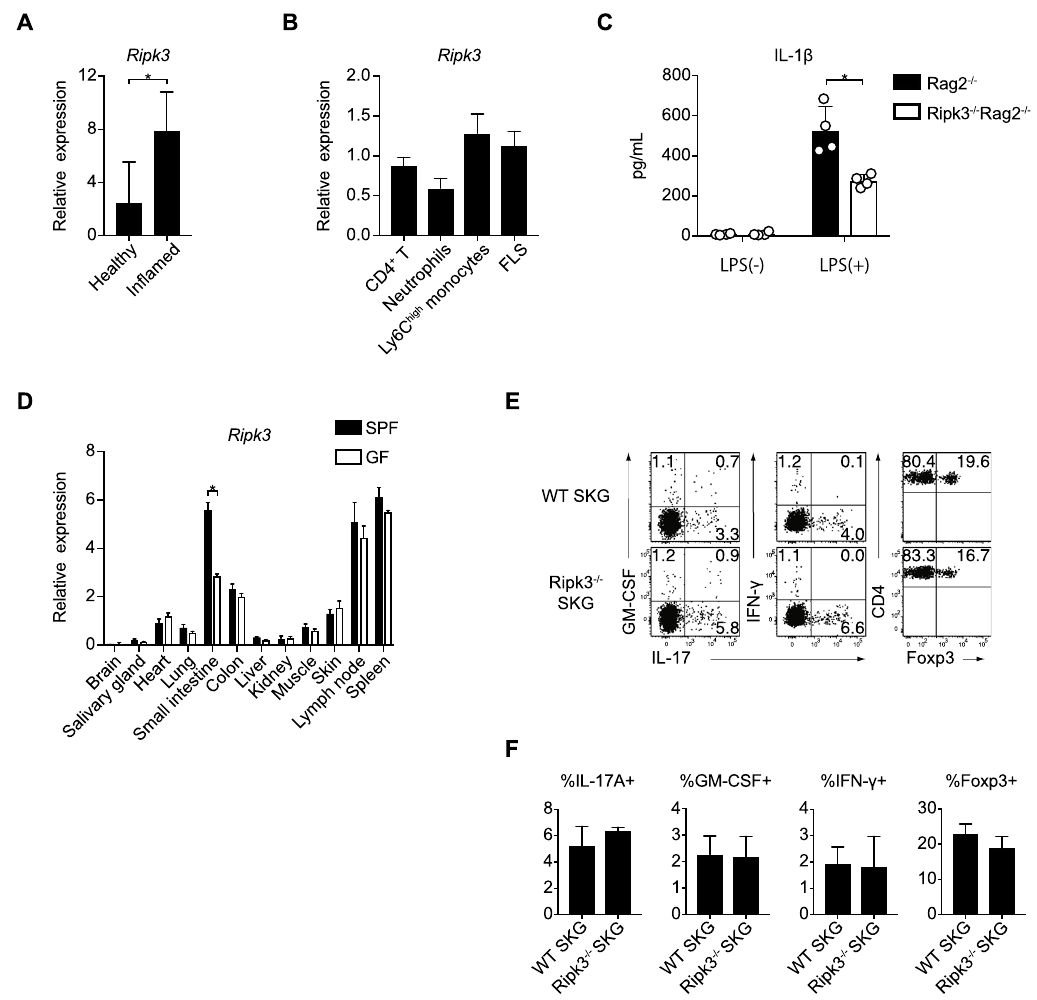
Figure 3. The Ripk3 expression in tissues and inflammatory cells and CD4 + T cell profiles in Ripk3 −/− SKG mice. ( A ) Quantitative RT-PCR to detect the expression of Ripk3 in whole synovial tissues of healthy and inflamed joints (n = 4 each). ( B ) Quantitative RT-PCR to detect the Ripk3 mRNA expression in CD4 + T cells, CD11b + Ly6G + neutrophils, CD11b + Ly6G - Ly6C high inflammatory monocytes and CD45 - CD31 - Podoplanin + FLS in inflamed joints (n = 4 each). ( C ) The IL-1β concentration of culture supernatant of BMDCs at 16 h after LPS stimulation (n = 4 each) ( D ) Quantitative RT-PCR to detect the expression of Ripk3 in the indicated organs of BALB/c mice housed under SPF or GF conditions (n = 4 each). ( E , F ) Flow cytometry of IL-17A + , GM-CSF + , IFN-γ + (n = 3 each) and Foxp3 + cells (n = 4 each) in CD4 + T cells in Peyer’s patches of WT and Ripk3 −/− SKG mice. The vertical bars denote the SD in panel (A–C,F) and SEM in panel (D) . * P < 0.05. Data are pooled from two independent experiments in panels ( A–D,F)